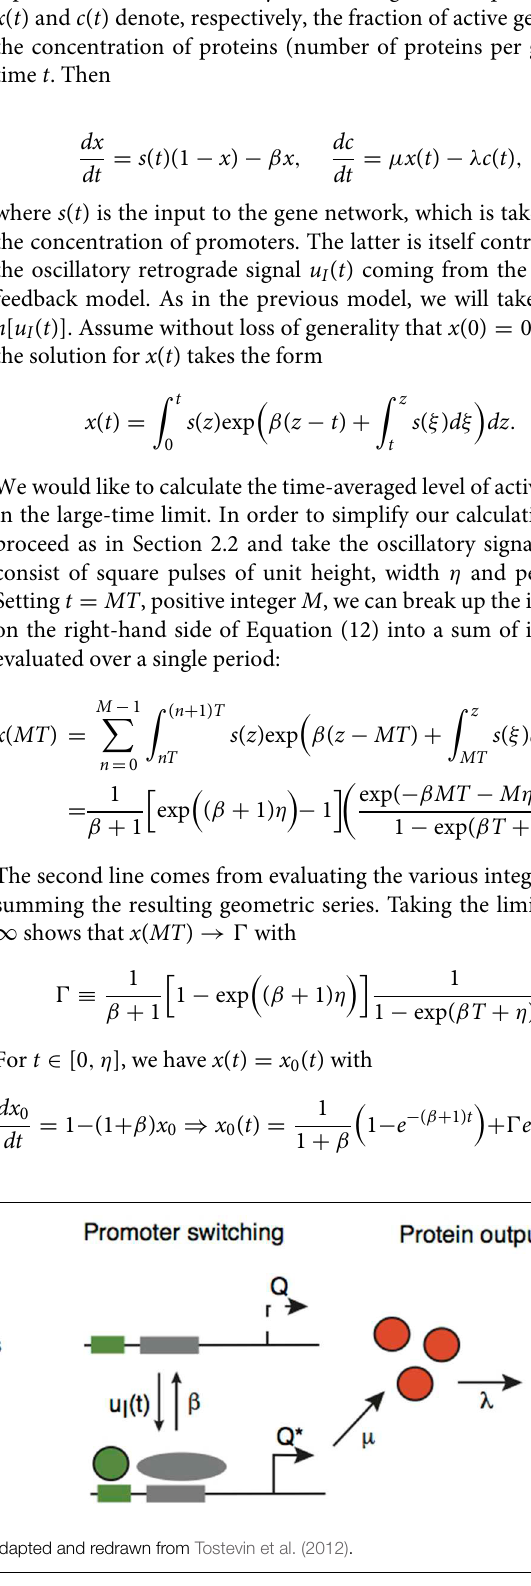
Frontiers in Cellular Neuroscience |